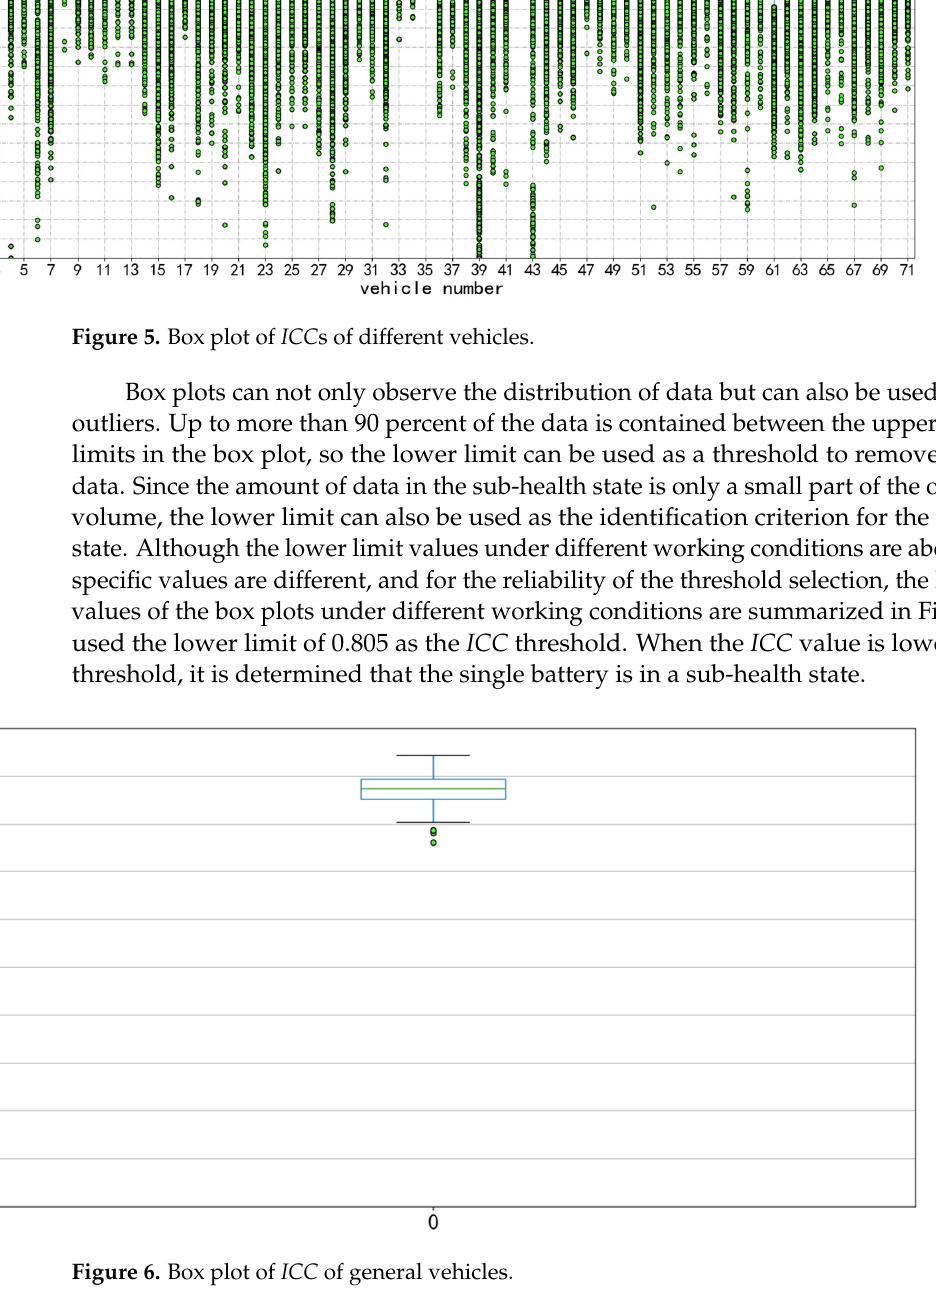
of single batteries, the ICC s of V 𝑗 , 𝑑𝑖𝑓𝑓 and V (cid:3365)